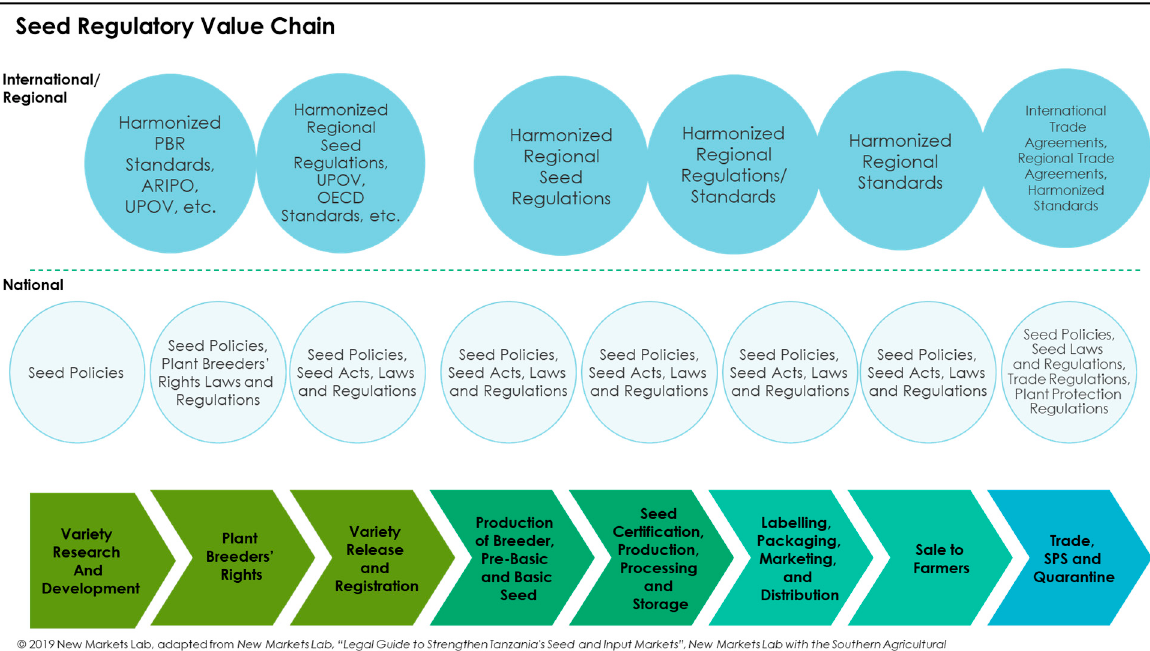
Figure 1. Seed regulatory value chain (adapted from [2]). Key: Plant Breeders’ Rights (PBR); African Regional Intellectual Property Organization (ARIPO); International Union for the Protection of New Varieties of Plants (UPOV); Organisation for Economic Co-operation and Development (OECD); and Sanitary and Phytosanitary Measures (SPS).